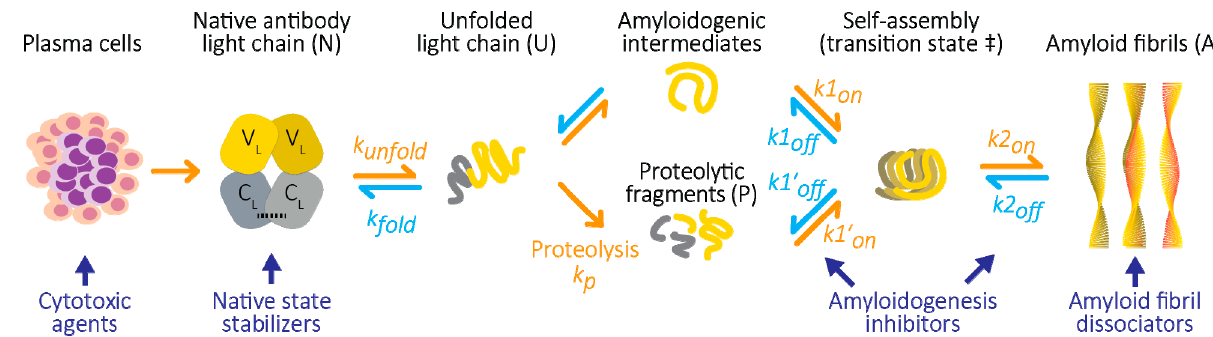
Figure 1. Amyloid formation by antibody light chains. In AL amyloidosis, LCs, shown here as a homodimer, are secreted from a clonal population of plasma cells. Once in circulation, LCs can unfold to amyloid-competent structural states, which may involve proteolysis. Inter-molecular interactions within this population of non-native structures can lead to the formation of polymeric species, including amyloid fibrils. Processes that lead to amyloid formation are shown as orange arrows, while those which antagonize amyloidogenesis are shown as cyan arrows. Reversible processes are shown as equilibria. Reaction rates for these processes can in some cases be calculated. The folding and unfolding rate constants of the native LC are defined as k fold and k unfold , respectively. The self-assembly process is divided into initiation and elongation steps, with rate constants k1 on/off and k2 on/off , respectively. Proteolysis is irreversible with a rate constant of k p , and leads to self-assembly of fragments with rate constants k1 ′ on/off . LCs can form multiple fibril structures. Therapies for AL amyloidosis (blue text and arrows) could potentially target any of these steps, which implies that combining therapies with different mechanisms of action could benefit patients. Existing treatments aim to kill the clonal cells that secrete the LCs. Alternative treatments could suppress formation of non-native amyloidogenic LC species (stabilizers), inhibit self-association (amyloidogenesis inhibitors), or promote the dissolution or removal of existing amyloid fibrils (amyloid dissociators).